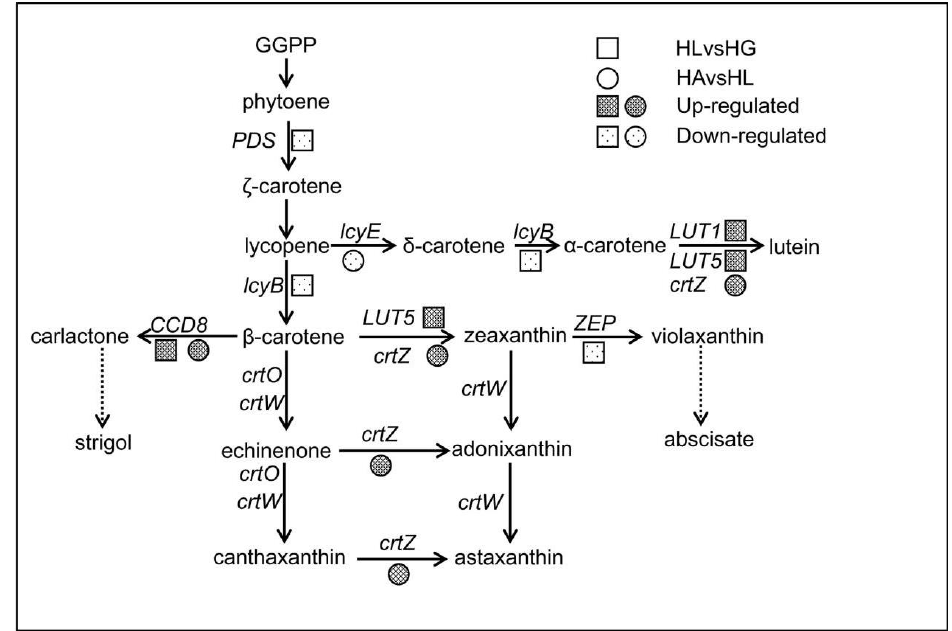
Figure 7. The pathways involved in carotenoid biosynthesis. The “solid arrow” means the related genes are showed in figure and the “dotted arrow” means the genes associated with the pathway are omitted. GGPP: geranylgeranyl pyrophosphate; PDS: phytoene desaturase; ZEP: